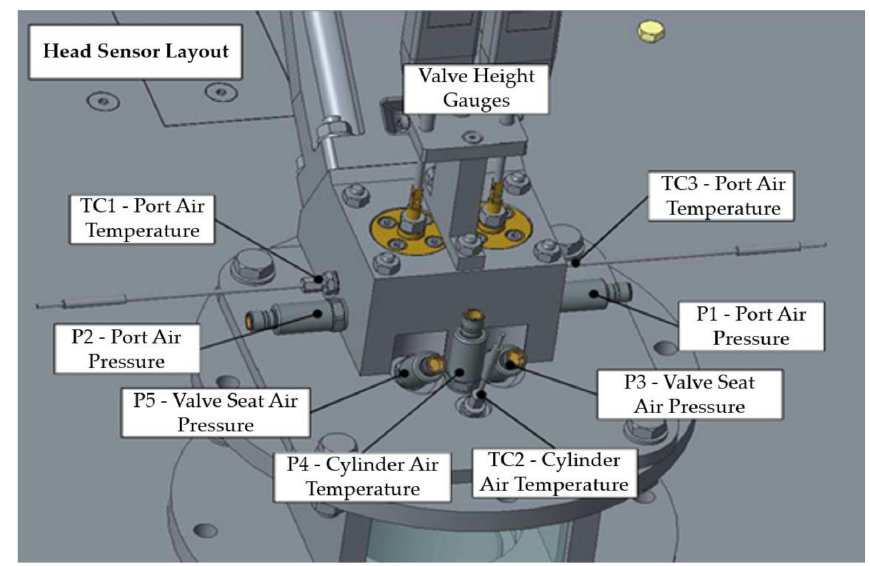
Figure 6. ARMC flow rig head sensor layout.